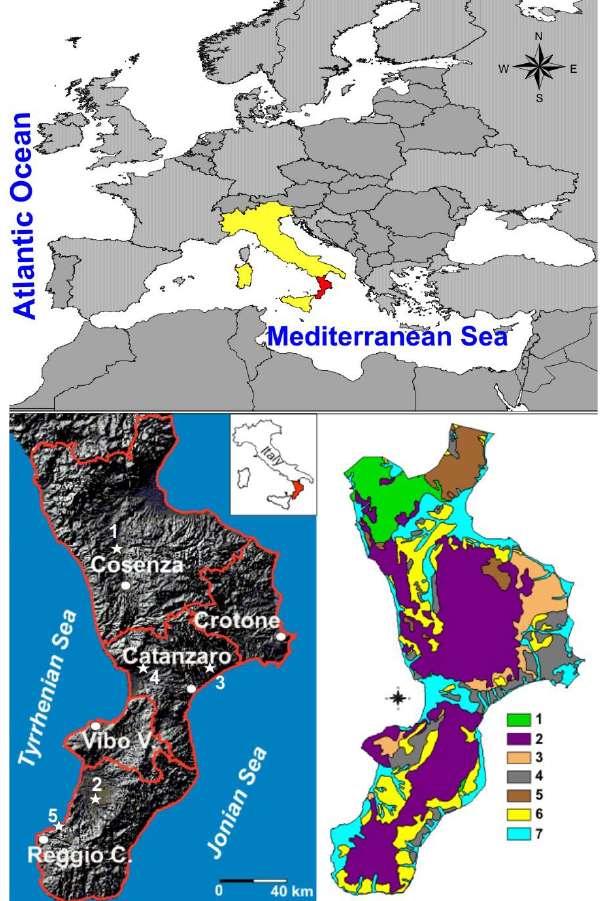
Fig. 1. Top: Mediterranean basin: Italy in yellow and Calabria in red. Bottom left: shaded relief map of Calabria and province bound- aries (Abbreviations: Reggio Calabria = Reggio C.; Vibo Valen- tia = Vibo V.). White stars indicates some places quoted in Sect. 3 (1: Tarsia; 2: Taurianova; 3: Cropani; 4: Lametia Terme; 5: Scilla). Bottom right: simplified geological sketch of the region. Keys: (1) limestone and dolostone; (2) metamorphic and igneous rocks; (3) clays, marls and evaporitic rocks; (4) sandstones, marly clays and limestone marls; (5) flysch and clayey formations; (6) conglom- erates, sands and sandstones; and (7) alluvial deposits.